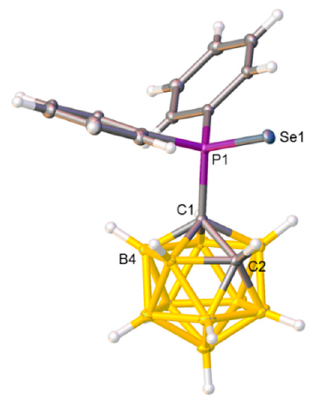
Figure 2. Molecular structure of compound 2 . Selected interatomic distances (Å): C1 − C2 1.6511(14), C1 − P1 1.8869(10), and P1 − Se1 2.1037(3).